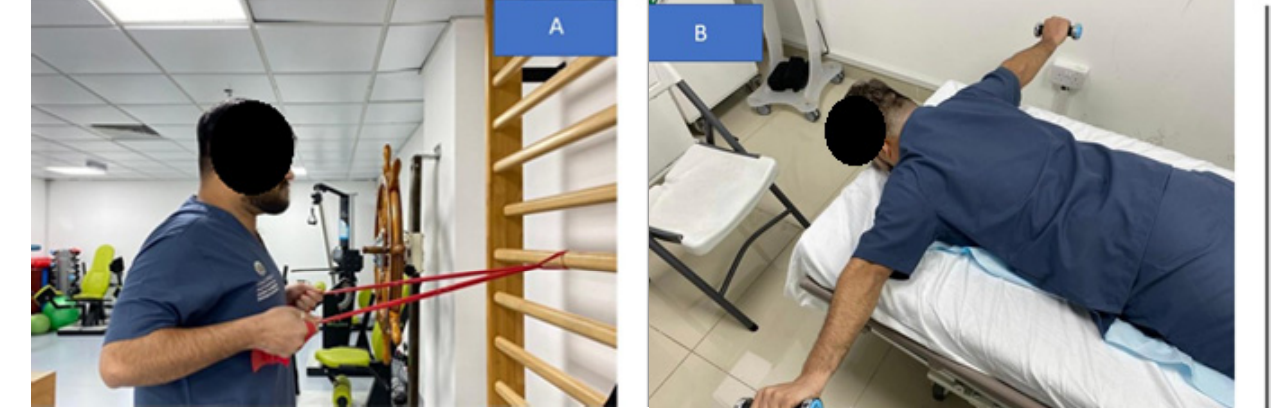
Figure 6. Scapular retractors strengthening exercise: ( A ) pulling the shoulders back using a theraband for resistance while standing to strengthen the shoulder retractors; ( B ) the initial progression step was to use weights to do shoulder retraction from a prone posture.